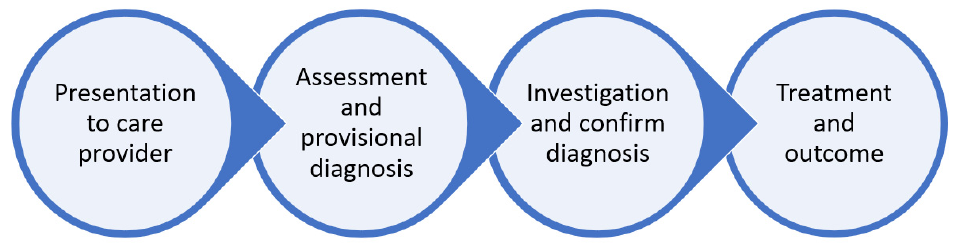
Figure 4. The ideal care pathway.